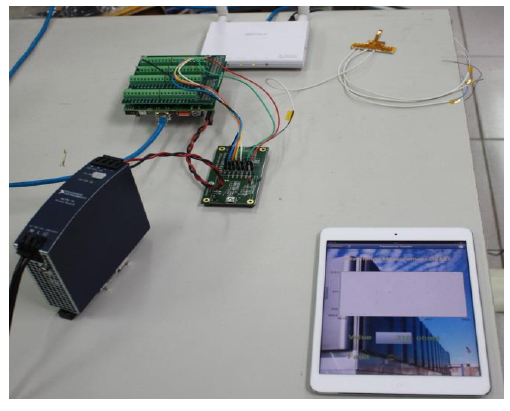
Figure 8. National Instruments (NI) wireless data module.